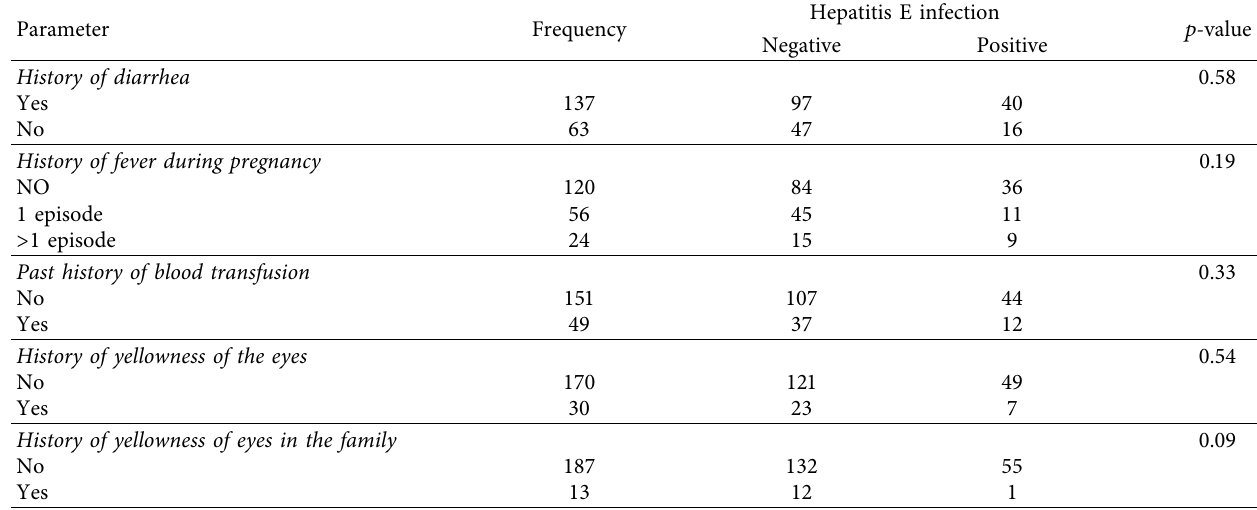
Table 3: Symptoms of hepatis E Infection among the study participants.